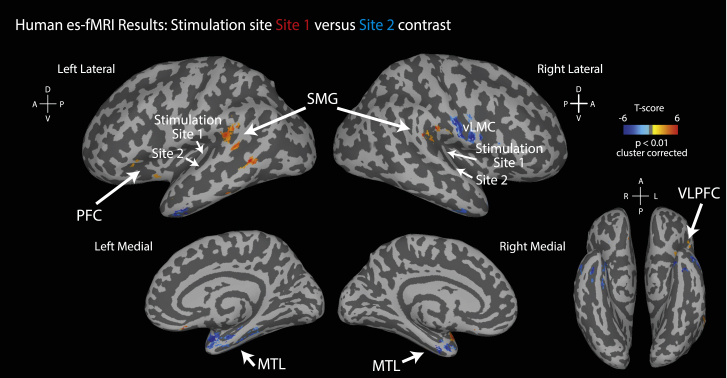
Human results contrasting site 1 versus site 2 es-fMRI effectsSame format as in Figures 3C and 3D, showing statistically significant (p < 0.01 cluster-corrected) effects where either site 1 (red color map) or site 2 (blue color map) was stronger. The corresponding contrast in monkeys yielded no cluster-corrected differences. SMG, supramarginal gyrus; vLMC, approximate location of ventral laryngeal motor cortex within M1.